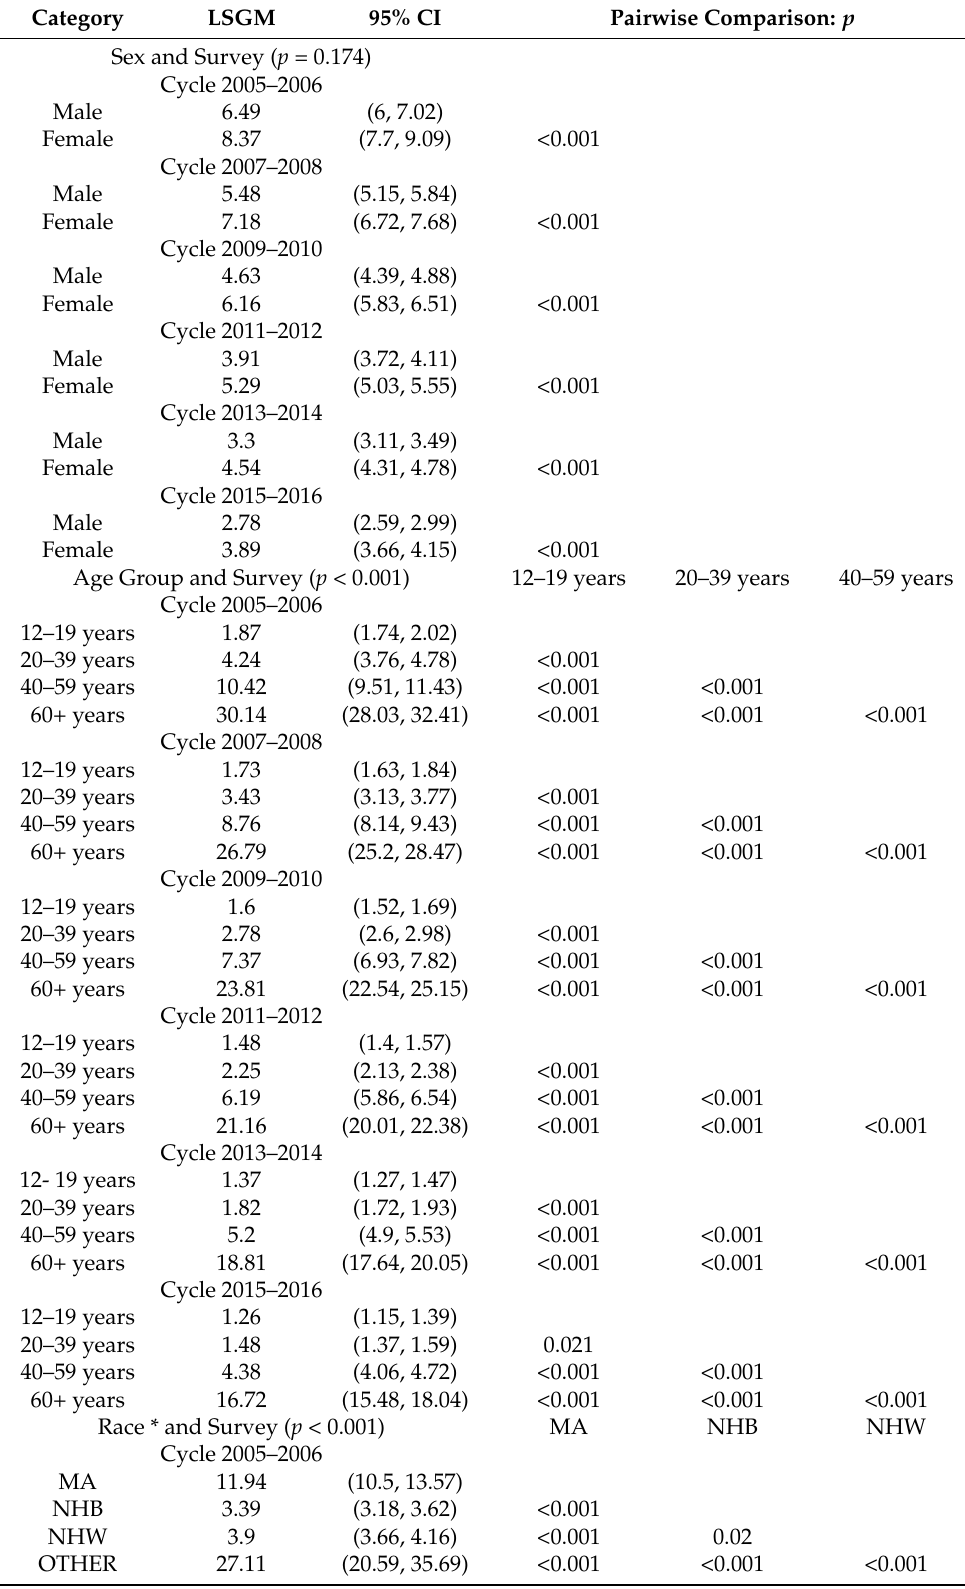
Table 3. LSGM (ng/g Lipid) and 95% CI by Survey Cycles and Demographic Groups for β